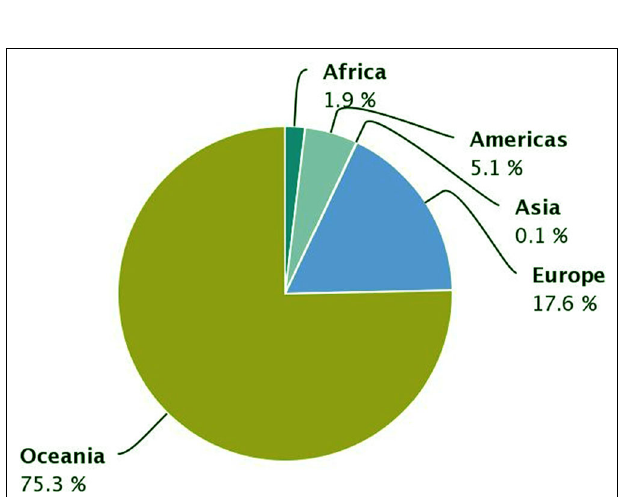
FIGURE 1 | Lupin cultivated areas and production in Europe. Source: FAOSTAT 2015.